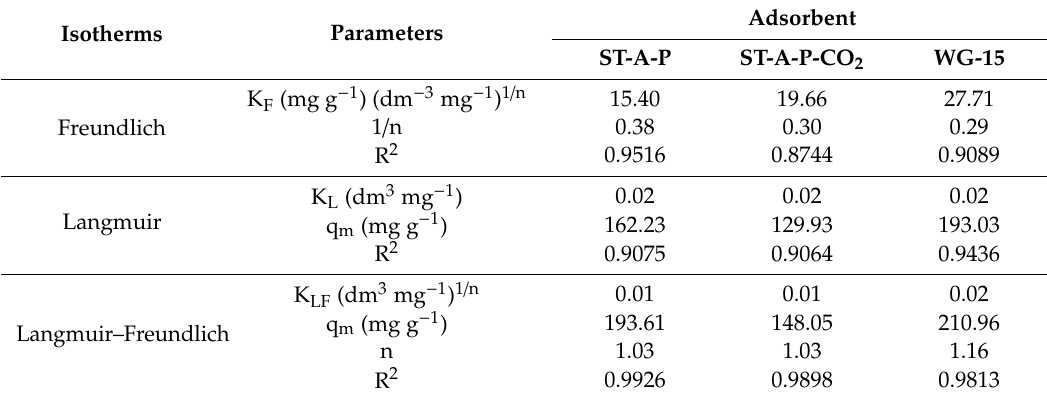
Table 10. Langmuir, Freundlich, and Langmuir-Freundlich equations parameters and correlation coe ffi cients R 2 for the adsorption of ibuprofen on the adsorbents.